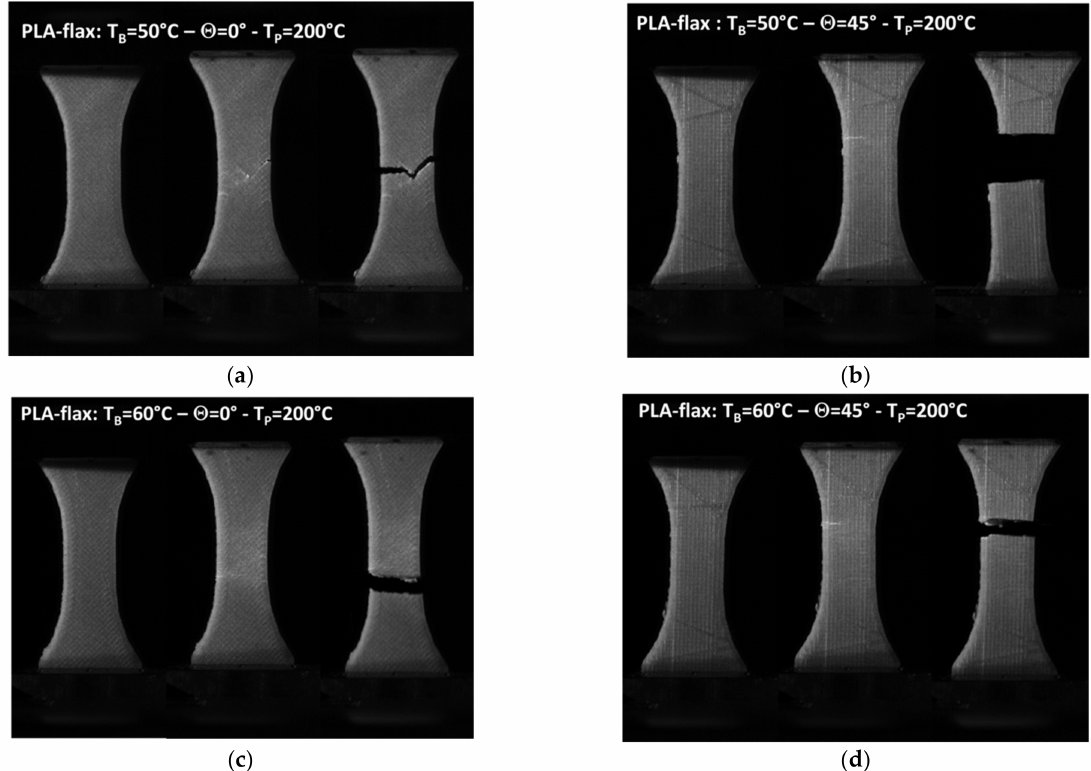
Figure 4. Snapshots of the deformed PLA-flax captured at 100 fps at different load levels (prior loading, prior rupture point, at rupture point) for T P = 200 ◦ C, and various combinations of bed temperature and printing angle: ( a ) T B = 50 ◦ C- Θ = 0 ◦ ; ( b ) T B = 50 ◦ C- Θ = 45 ◦ ; ( c ) T B = 60 ◦ C- Θ = 0 ◦ ; ( d ) T B = 60 ◦ C- Θ = 45 ◦